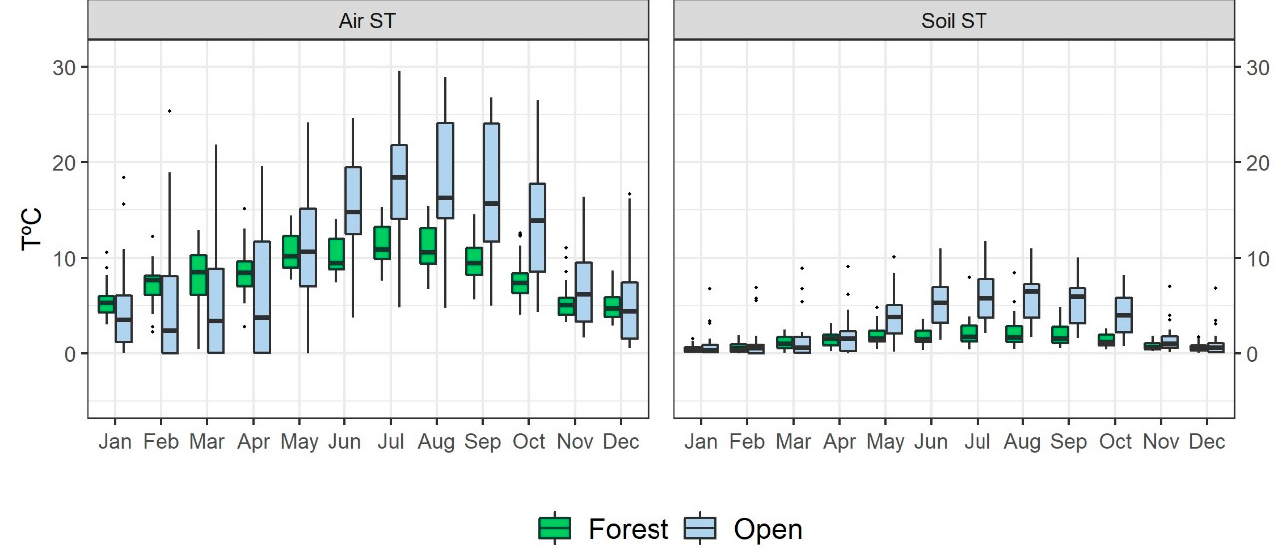
Figure 11. Boxplots to compare thermal stability in open and forested habitats over a full year-type in the PNOMP, both in the air and soil.